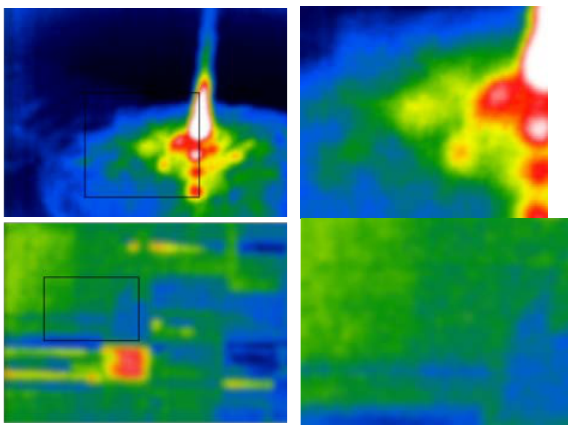
Fig. 6. The result of processing IR images proposed of the multicriteria method smoothing The images presented in Figure 6 show the effectiveness of the approach proposed in the work to reduce the effect of noise. Application of the multi-criteria method smoothing allows reducing the effects of noise while maintaining the boundaries of